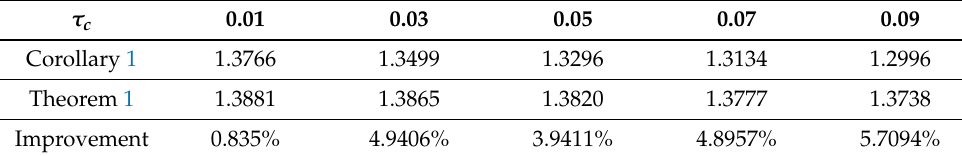
Table 1. The maximum sampling period d M for different τ c (Example 1).